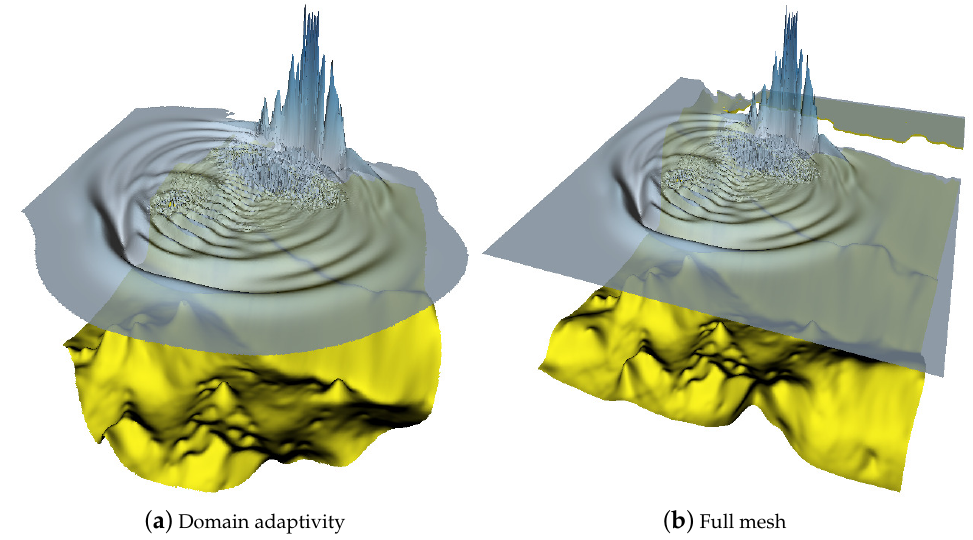
Figure 15. Passive generation: comparison between the bottom and the free surface elevation at t = 1500 s between the domain adaptation method and the full